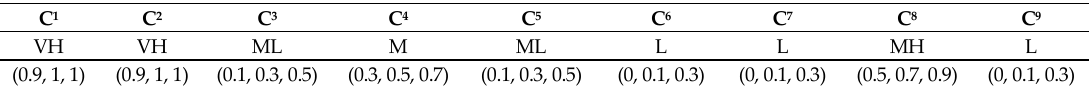
Table 6. Linguistic and fuzzy weights.